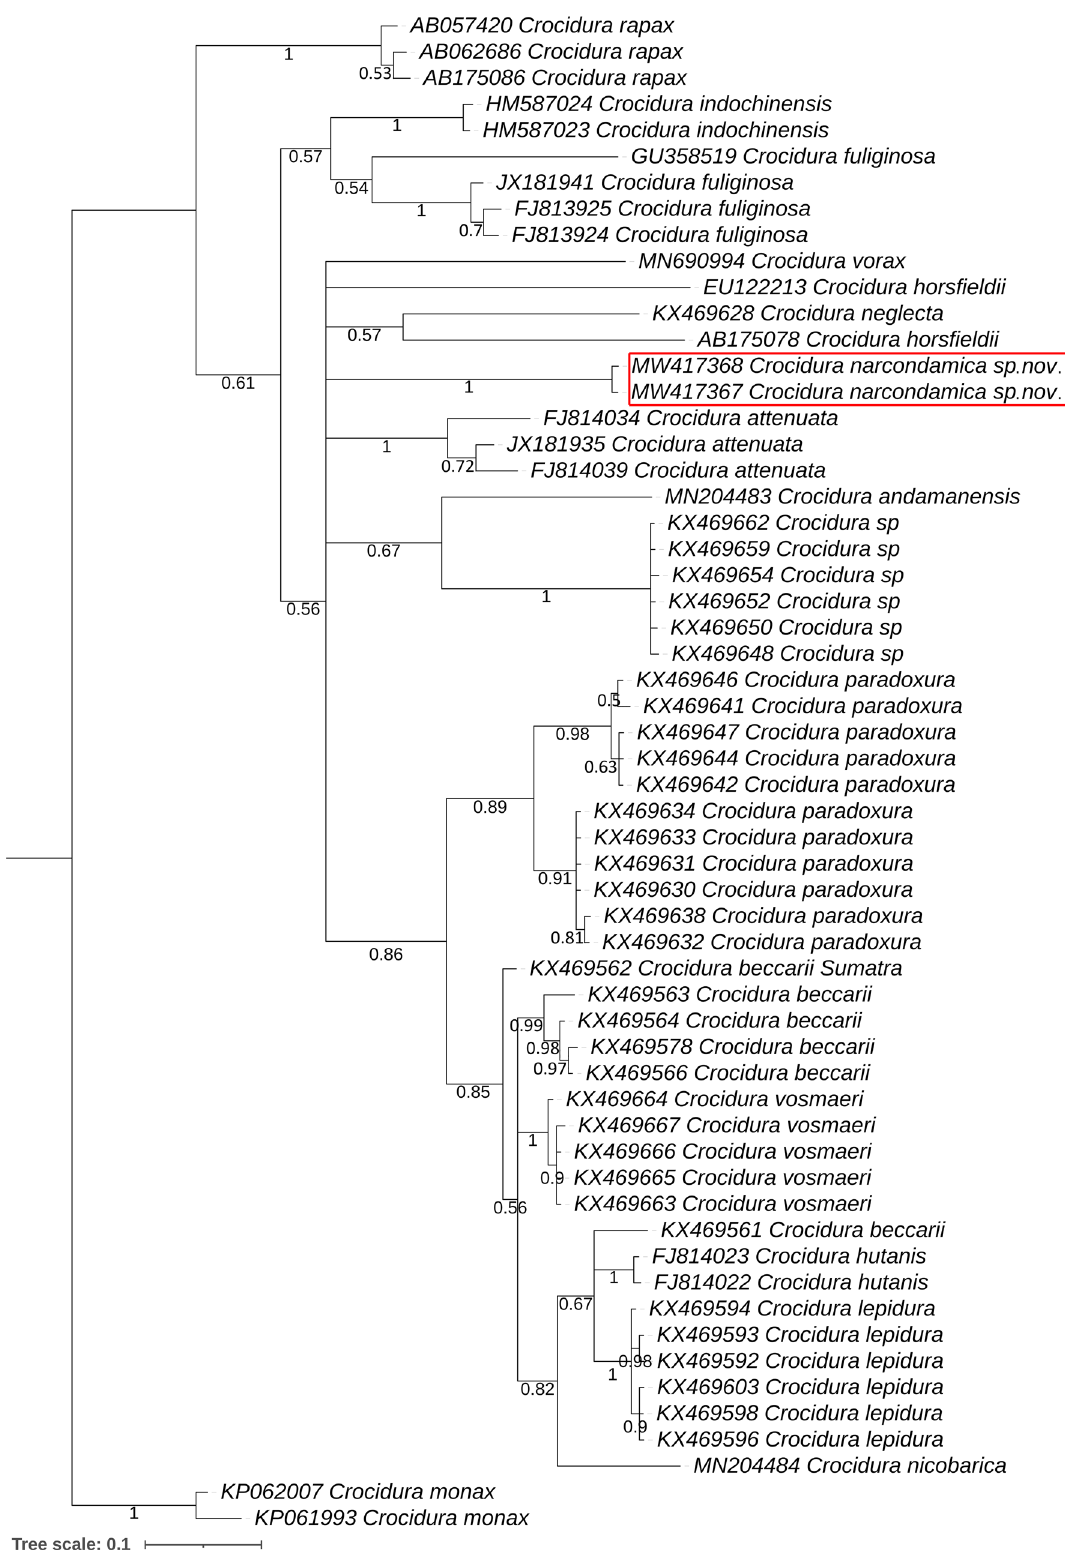
Figure 4. The Bayesian phylogenetic analysis of the mitochondrial Cytb gene depicted a distinct clustering of C. narcondamica sp. nov. in comparison with other Crocidura species distributed in the AN Archipelago, the mainland of India, Myanmar, and in Sumatra. The posterior probability supports are noted with each node. The GenBank accession numbers and species name are marked as per clade pattern. The distinct clade of the new species is marked by a red colour box. The figure was prepared in web-based iTOL tool (https:// itol. embl. de/) and edited manually in Adobe Photoshop CS